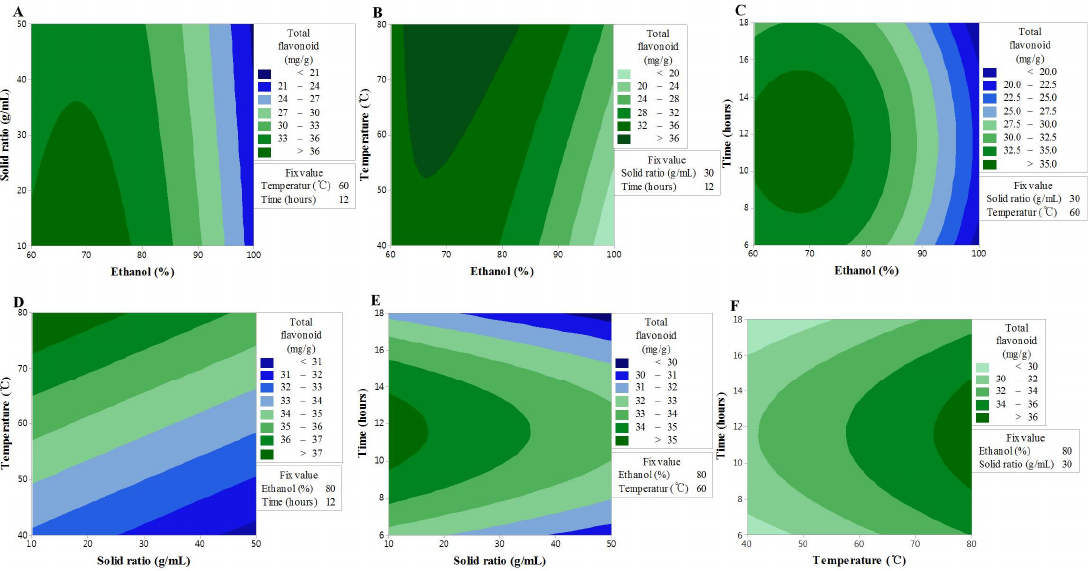
Figure 2. Contour plots showing the effect of ethanol concentration, solvent ratios, temperature, and time on Trolox equivalent antioxidant capacity. ( A ) solid ratios (g/mL) vs. ethanol concentration (%); ( B ) temperature (°C) vs. ethanol concentration (%); ( C ) time (h) vs. US ethanol concentration (%); ( D ) temperature (°C) vs. solid ratios (g/mL); ( E ) time (h) vs. solid ratios (g/mL); ( F ) time (h) vs. temperature (°C).